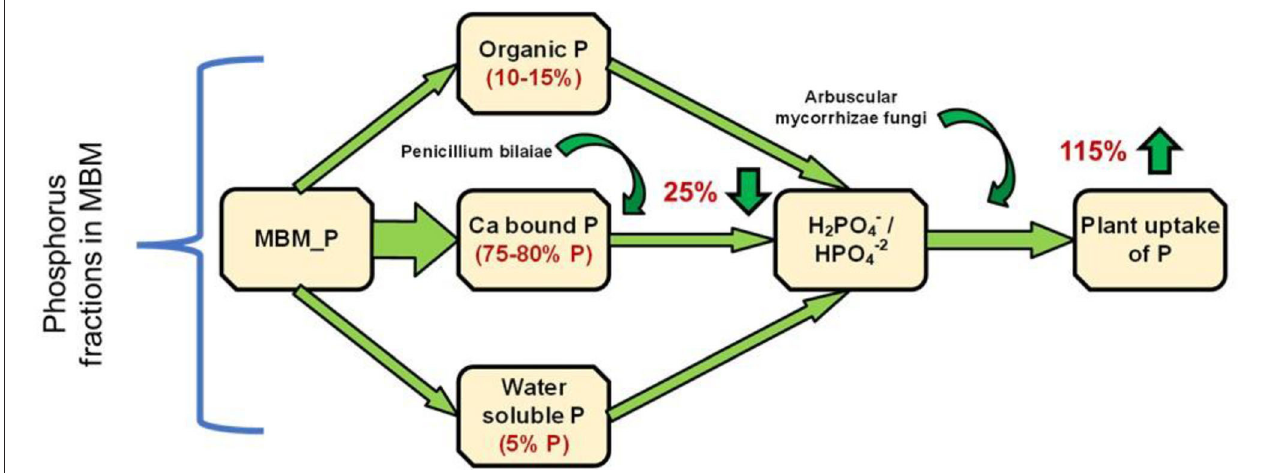
FIGURE 9 | Schematic diagram representing the different MBM_ phosphorous fractions and arbuscular mycorrhizae fungi, Penicillium bilaiae and their interaction effect for the mobilization of different MBM_P